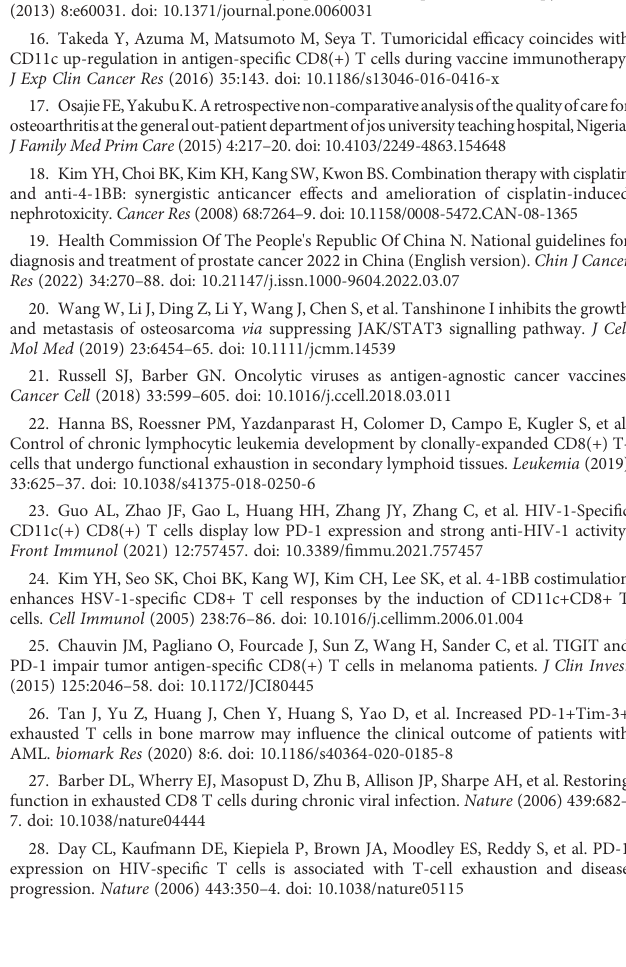
Gating strategy for fl ow cytometry analyses. Effector memory (CCR7 - CD45RA - ) (Tem), central memory (CCR7 + CD45RA - ) (Tcm), naïve (CCR7 + CD45RA + ), and effector (CCR7 - CD45RA + ) subsets, and CD38 & HLA-DR, PD-1, GB expression were identi fi ed on CD11c + and CD11c - CD8 + CD3 + T cells. The production of intracellular IFN- g , and TNF- a , and IL-2 and CD107a expression on cell membrane after PMA stimulation were identi fi ed based on CD11c + and CD11c - CD8 + CD3 + T cells. The numbers indicate the percentages of cells within the